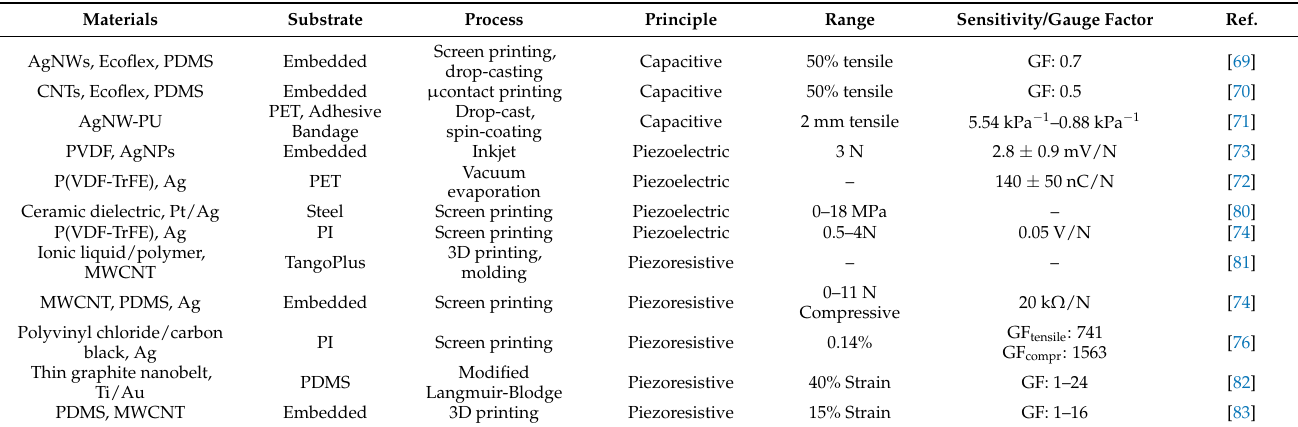
Table 5. Printed Mechanical Deformation Sensors.